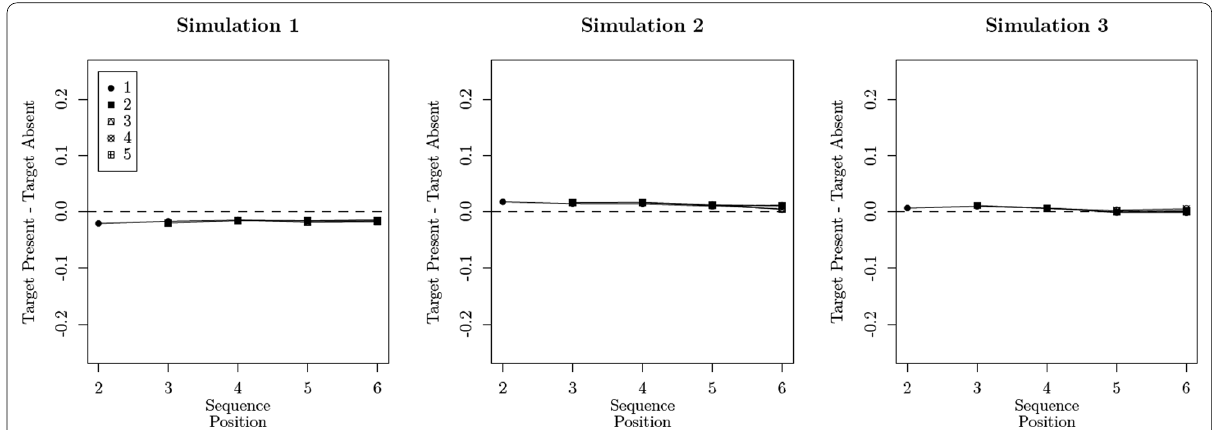
Fig. 17 Simulated differences in the conditional probability of responding “ yes ” in sequence position i between target-present and target-absent lineups. The different symbols distinguish the preceding position taken by the target in target-present